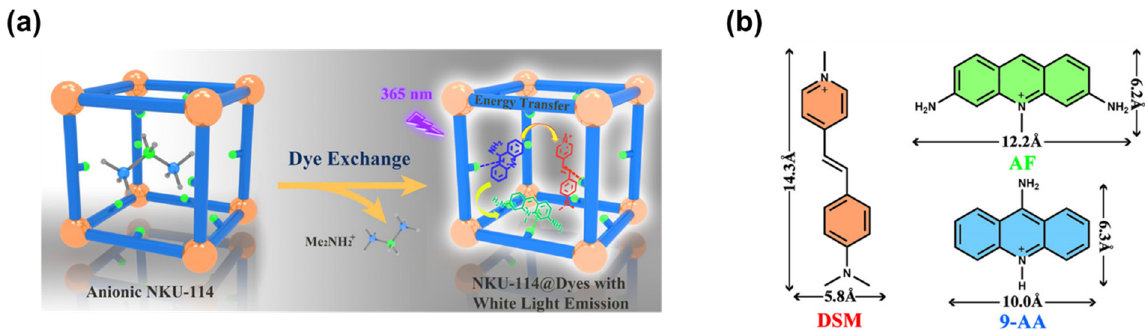
Figure 1. ( a ) Schematic representation of the incorporation of multicomponent dyes in an anionic MOF; ( b ) structures of cationic dyes. (Reproduced with permission from ref. [40]. Copyright © 2020, American Chemical Society).